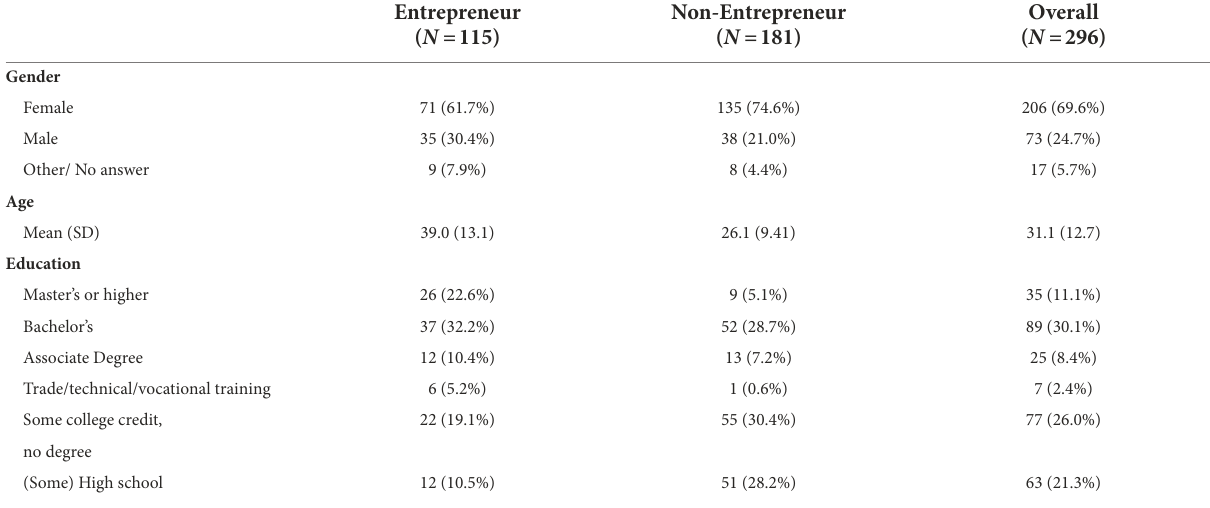
TABLE 1 Descriptive sample